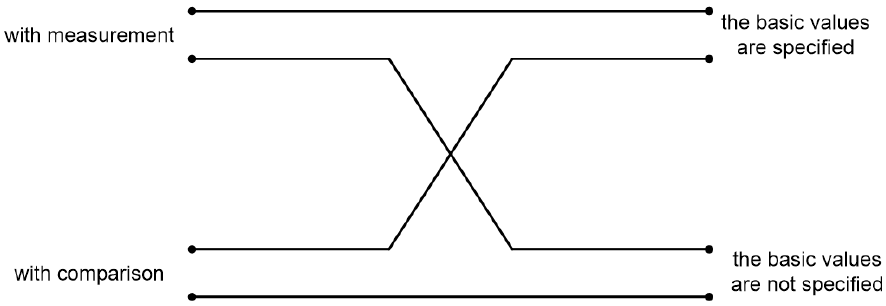
Figure 1. Possibilities of combinations of control charts